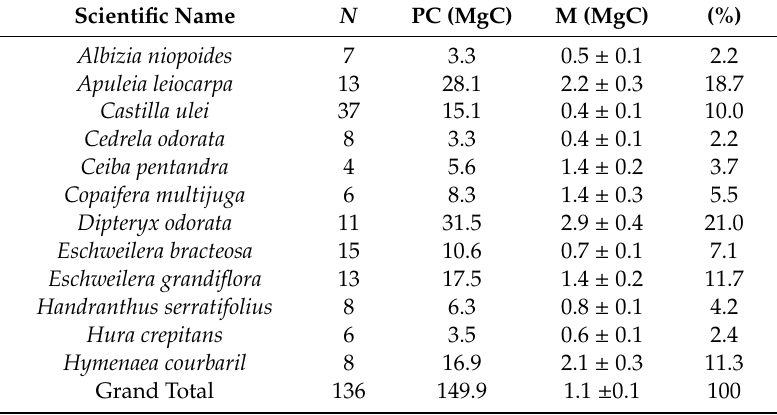
Table 4. Number of trees sampled per species (N), total carbon stored in sawn-wood products by species (PC, in MgC), mean ± standard error of the mean for carbon per harvested tree (M, in MgC), and percentage of carbon (%) for 12 tree species in a 1252.8-ha area harvested in a forest-management area in the state of Acre, Brazil.